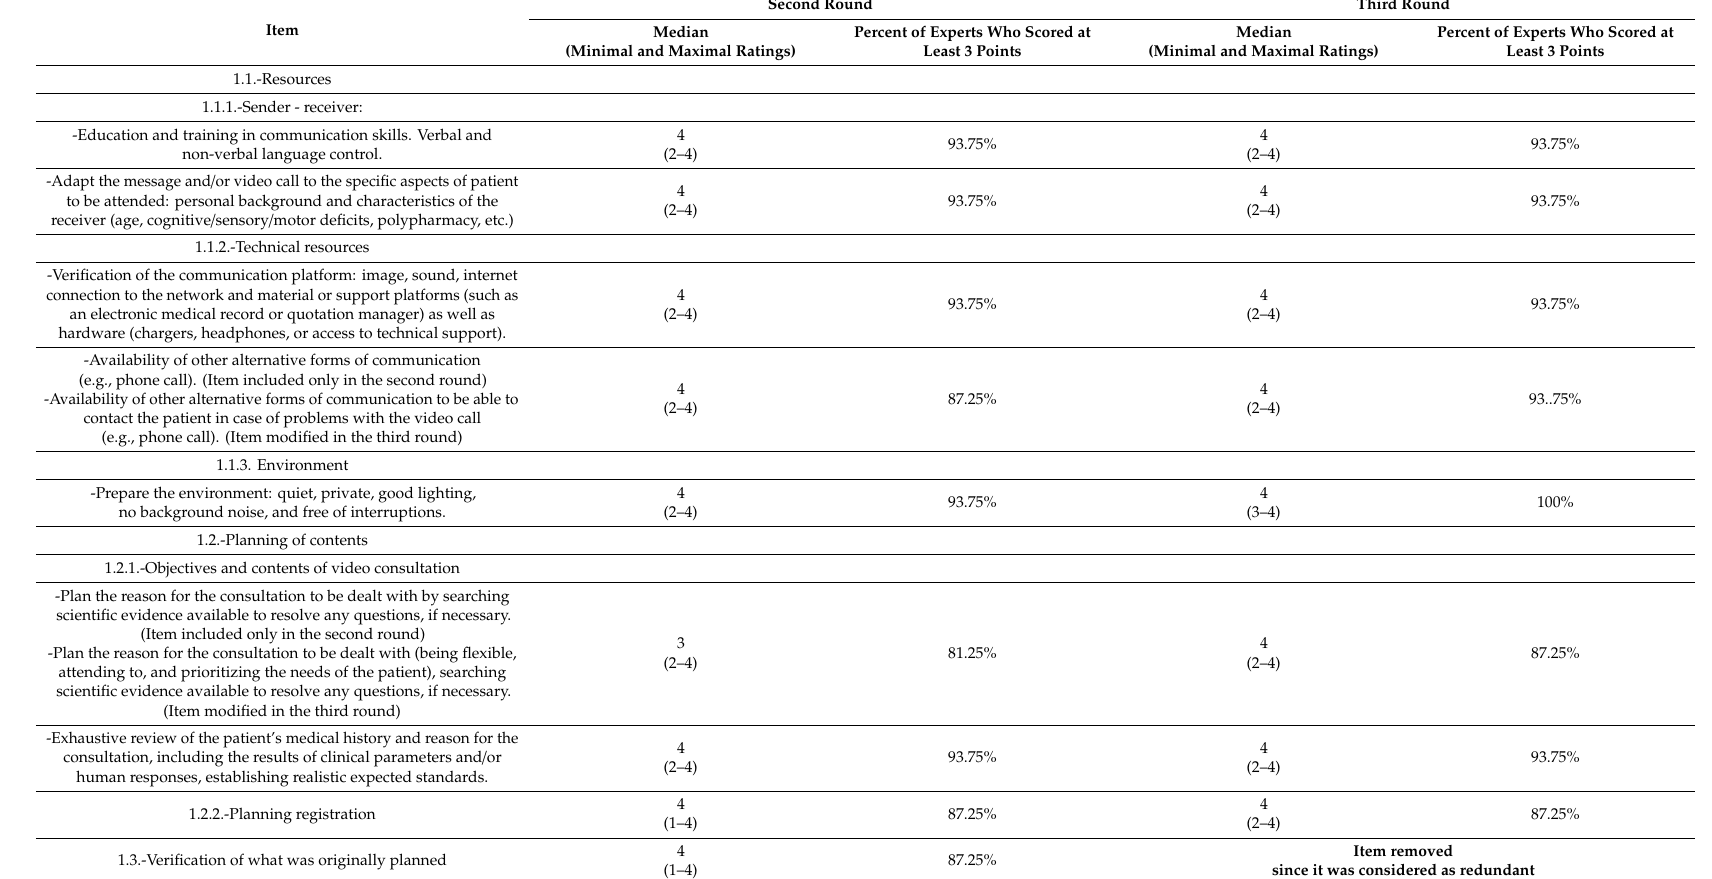
Table 2. Results of Delphi method: preparation of a video